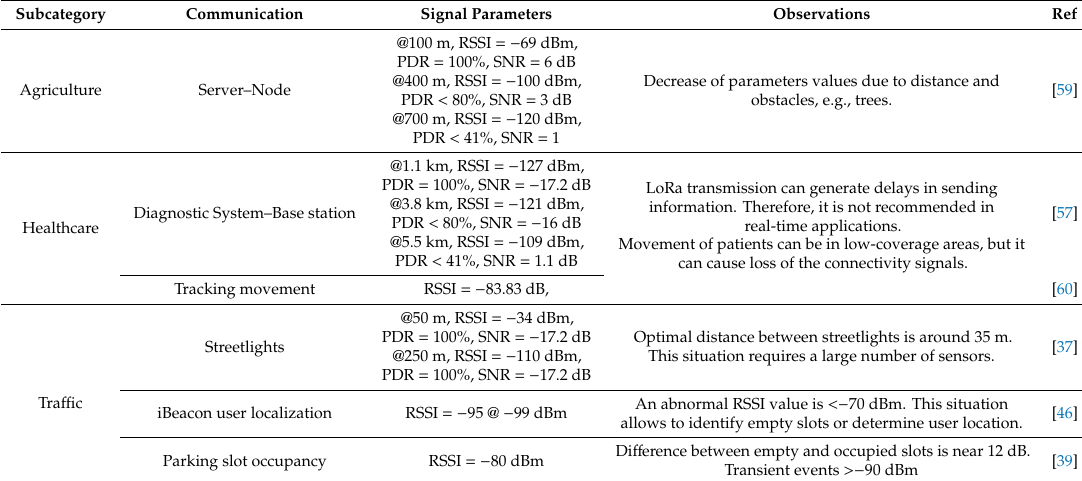
Table 8. Signal parameters (received signal strength level (RSSI), signal-to-noise ratio (SNR), packet delivery rate (PDR)) of subcategories of the smart